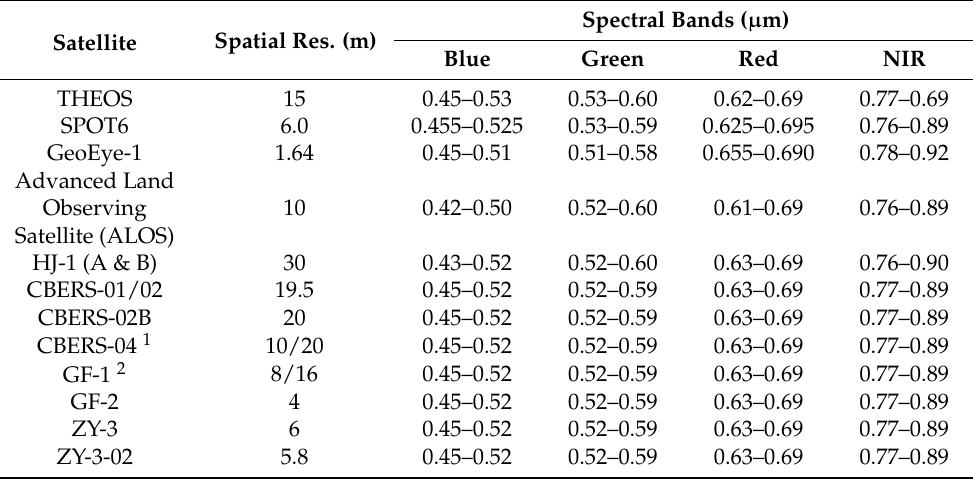
Table 1. Spatial and spectral specifications for medium- and high-resolution satellite data (NIR: near